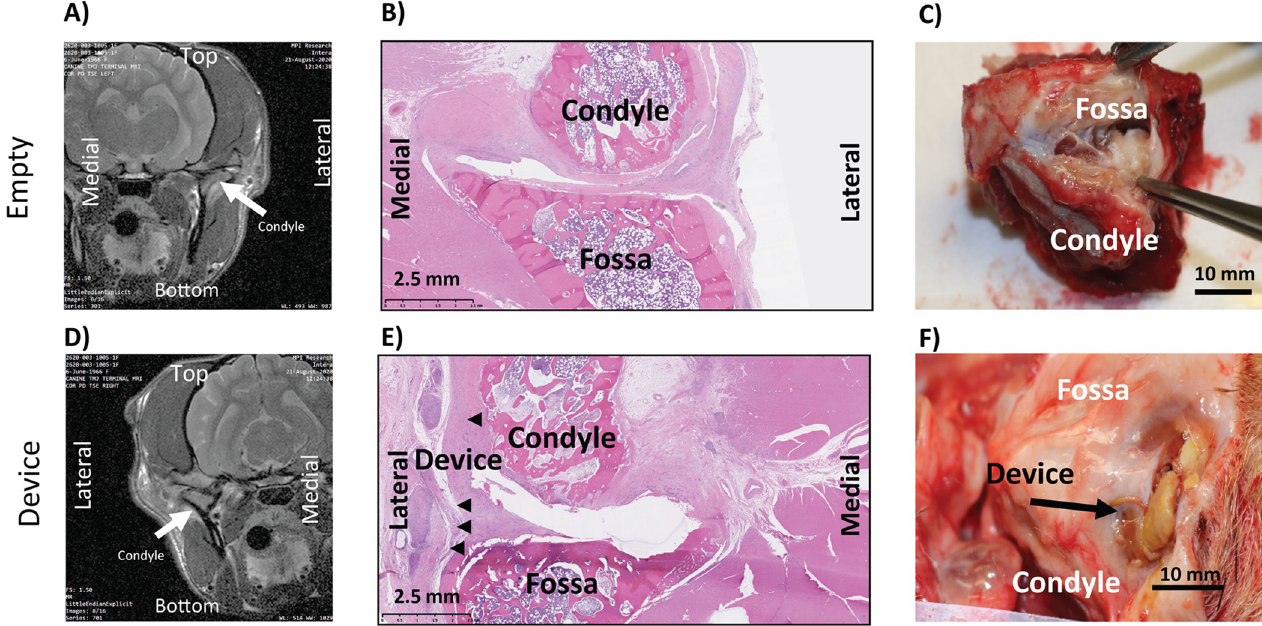
Fig 6. Animal 1005: Coronal MRI of empty (A) and implanted (D), Sagittal H&E of empty (B) and implanted (E), Necropsy Picture of empty (C) and implanted (F).